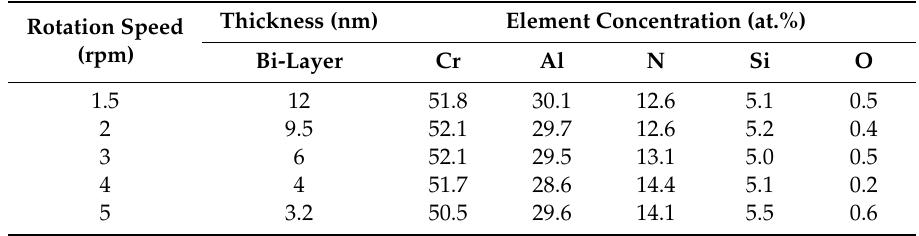
Table 2. Element concentration as a function of thickness in bi-layer CrAlSiN / CrN multilayer coatings. Thickness (nm) Element Concentration Rotation Speed (rpm)